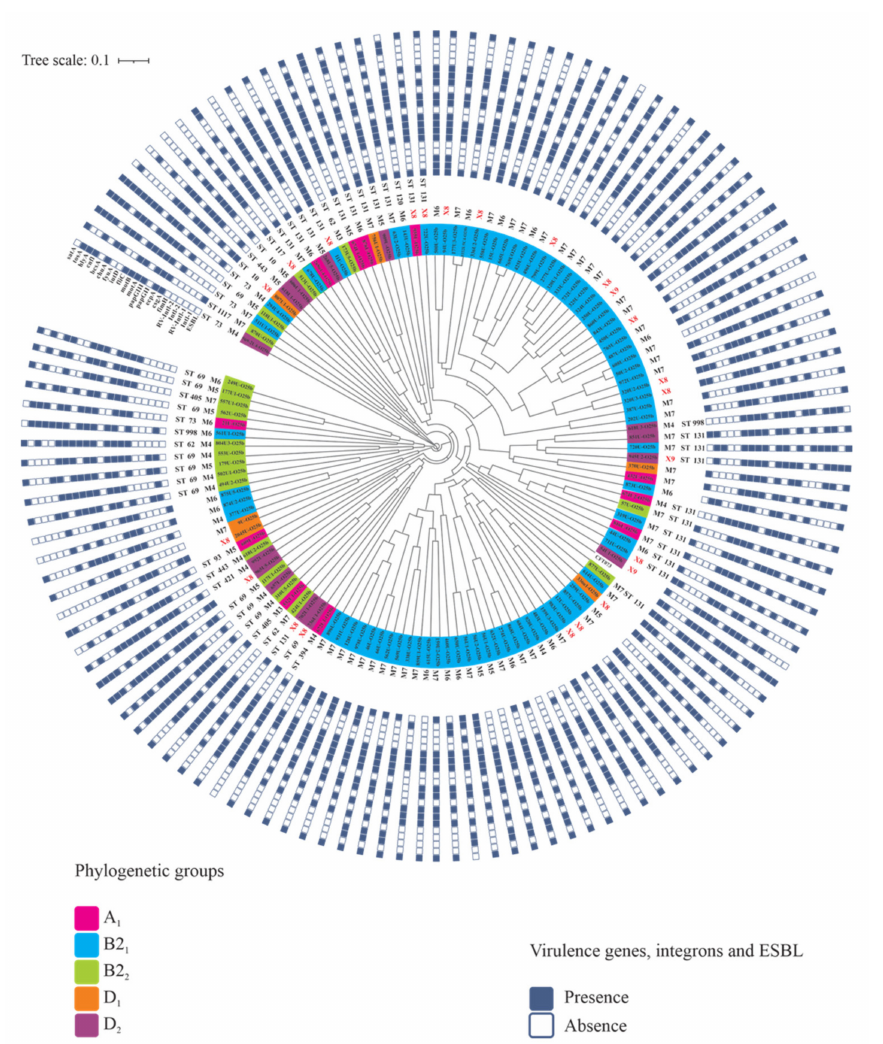
Figure 2. Genetic diversity determined by PFGE of the UPEC O25b clinical strains. The diversity analysis showed a cophenetic correlation coefficient value of r = 0.7917. ST: sequence type,